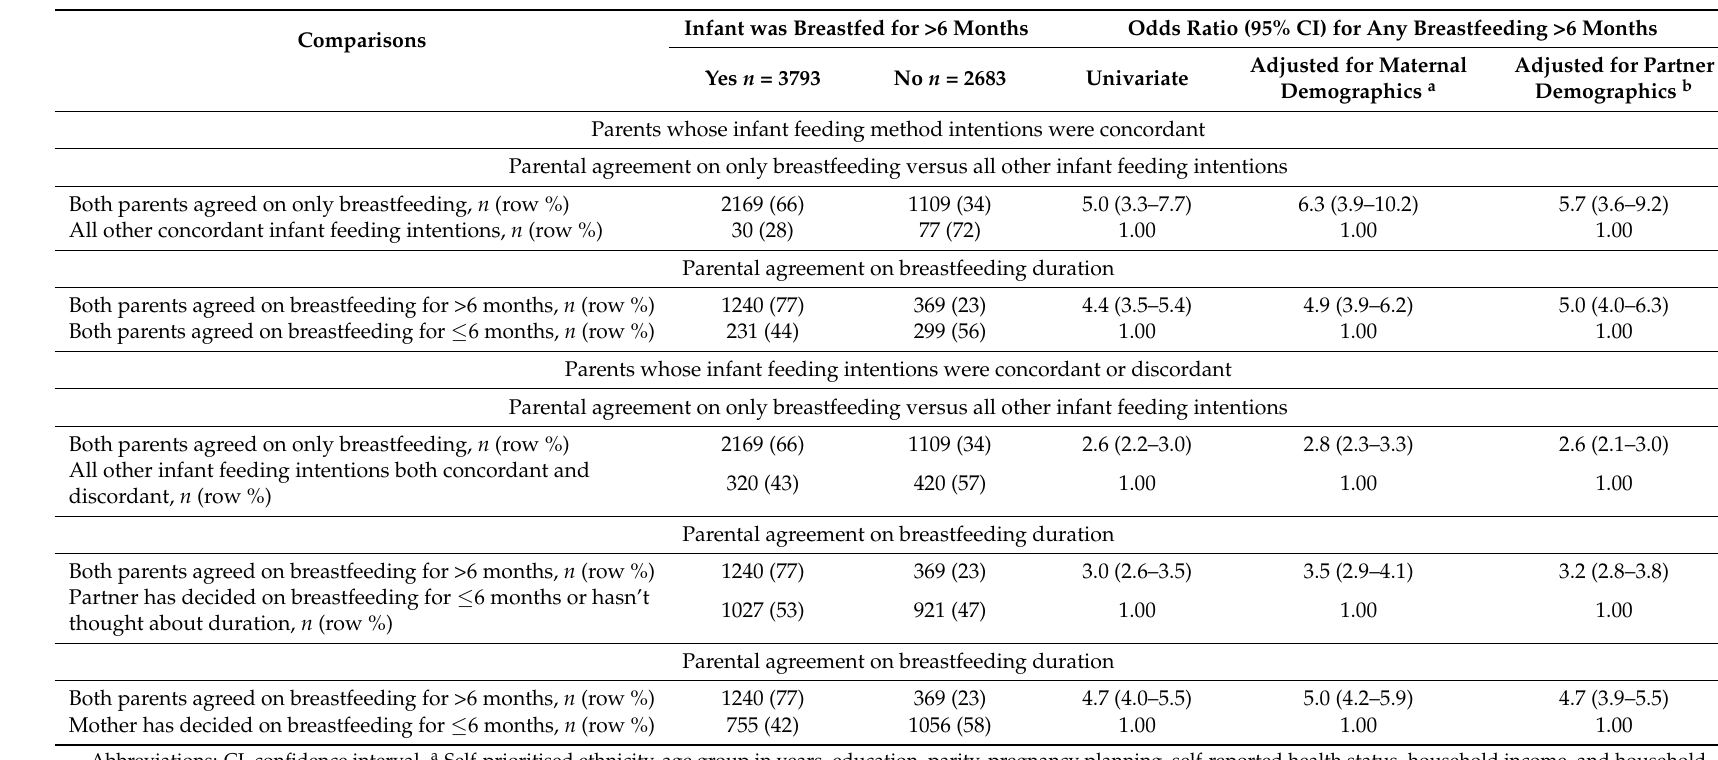
Table 5. Agreement between pregnant women and their partners on initial infant feeding method and breastfeeding duration for their infant. Infant was Breastfed for >6 Comparisons